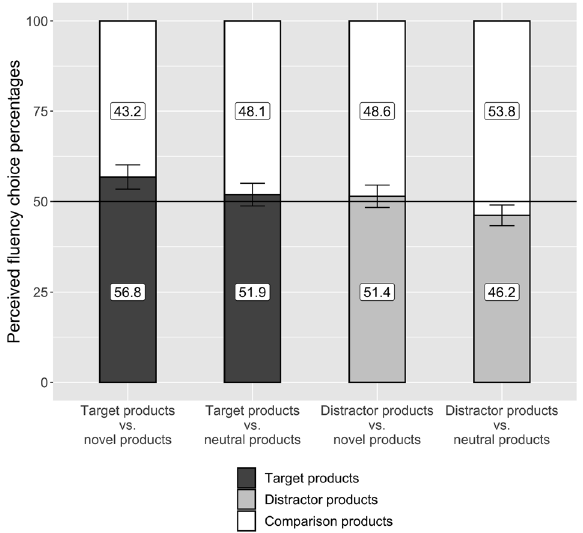
Figure 2. Perceived fluency choice percentages (Experiment 2). Perceived fluency choice percentages of the two-alternative forced-choice tasks in Experiment 2. Participants chose those choice options which they could perceive more fluently. Error bars show 95% confidence